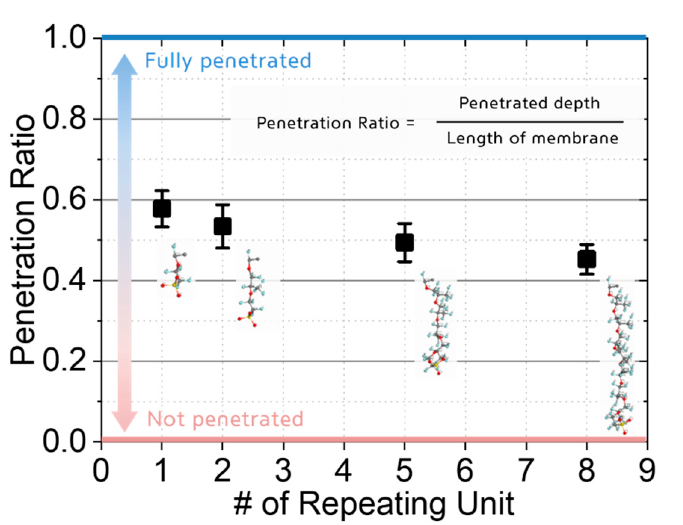
Figure 2. Relative concentration profile of hydrogen molecules. The simulation system is divided into penetrated and not penetrated regions. Their ratio is considered as a criterion for the compari- son of penetration as a result of the side chain morphology.